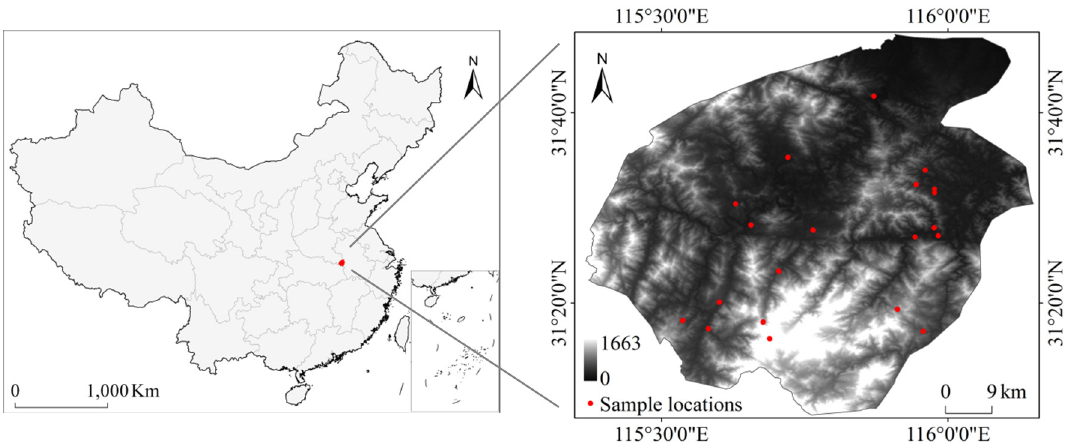
Figure 1. Location of the study area in China ( Left ) and the field-measured sampling plots (red dots) shown in a digital elevation model (DEM) ( Right ). At each of the twenty-one field sampling plots, two reference plots were established. The total number of reference plots thus equals